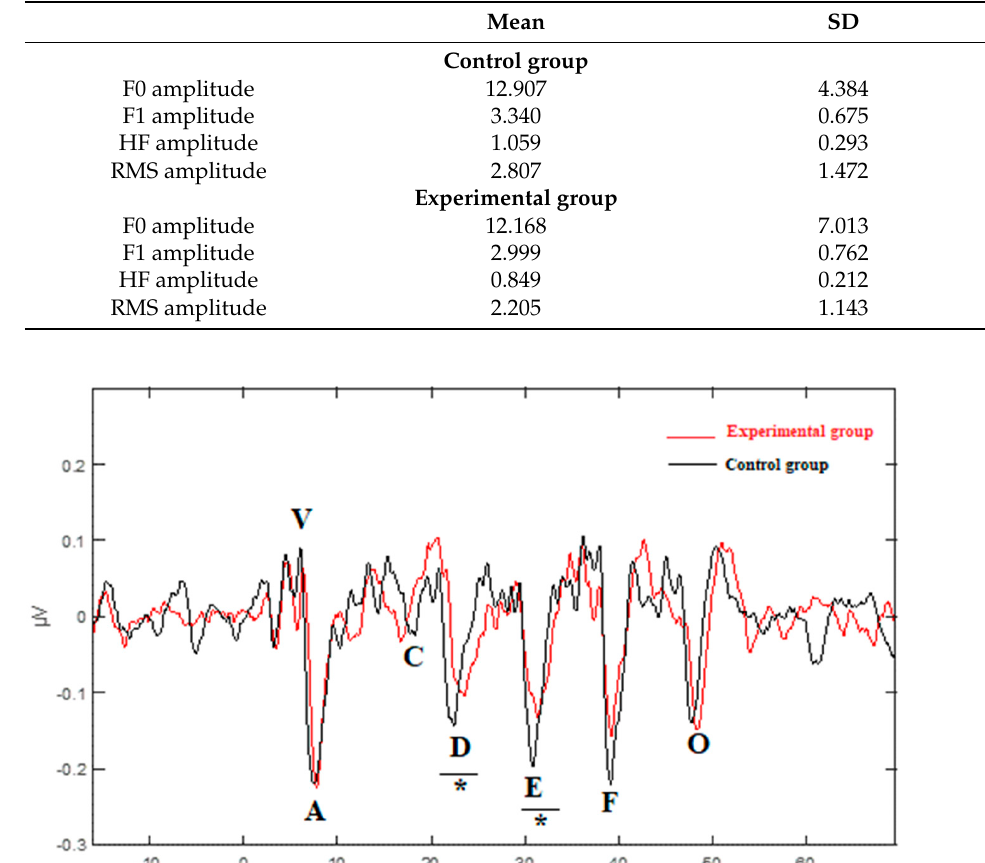
Figure 1. Grand average of speech-evoked ABR in the experimental (red) and control (black) groups. * Significantly different between groups ( p < 0.05).